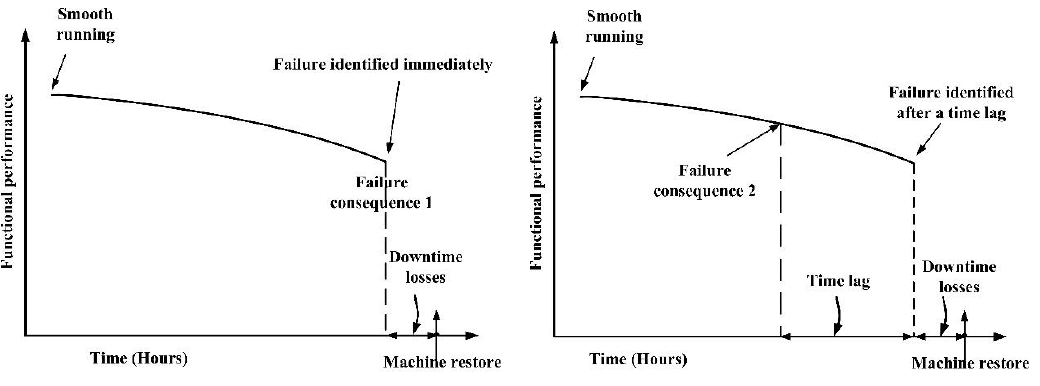
Figure.1 Machine tool failure on time-performance